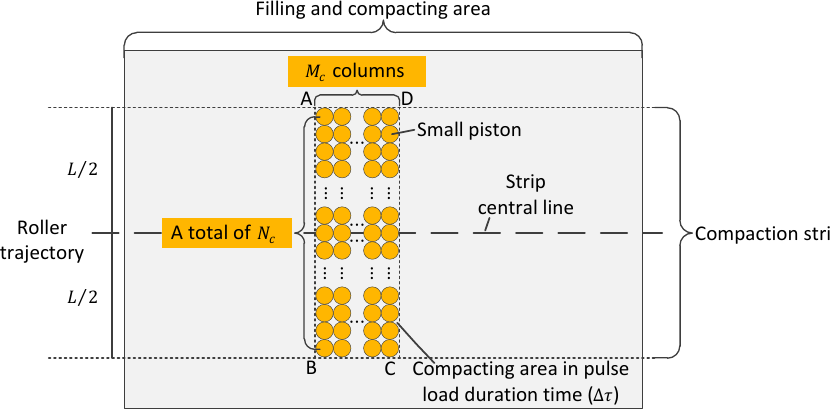
Figure 7. Diagrammatic sketch of compacting area in pulse load duration time ( ∆ τ ).